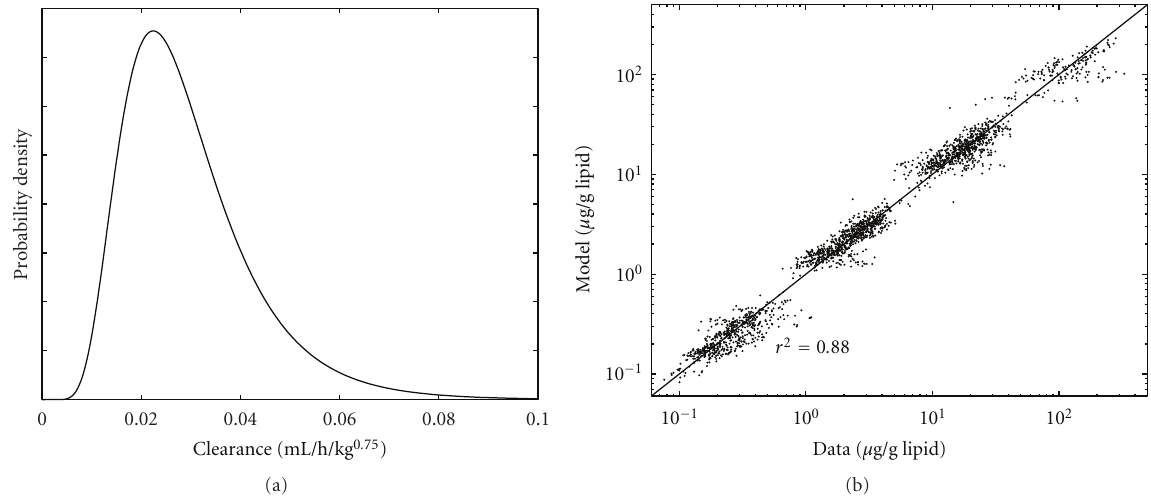
Figure 5: Population distribution of consolidated basal metabolic clearance v all 0 (a), and scatter plot of PBTK model predictions versus measured data using the optimized individual-level values of the Markov chains